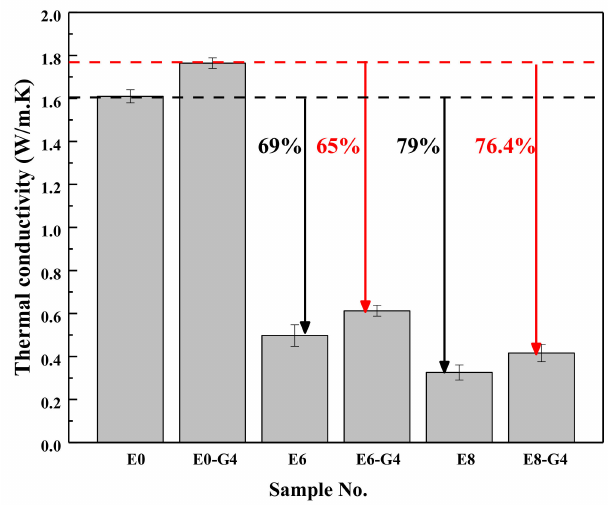
Figure 11. Thermal conductivity of